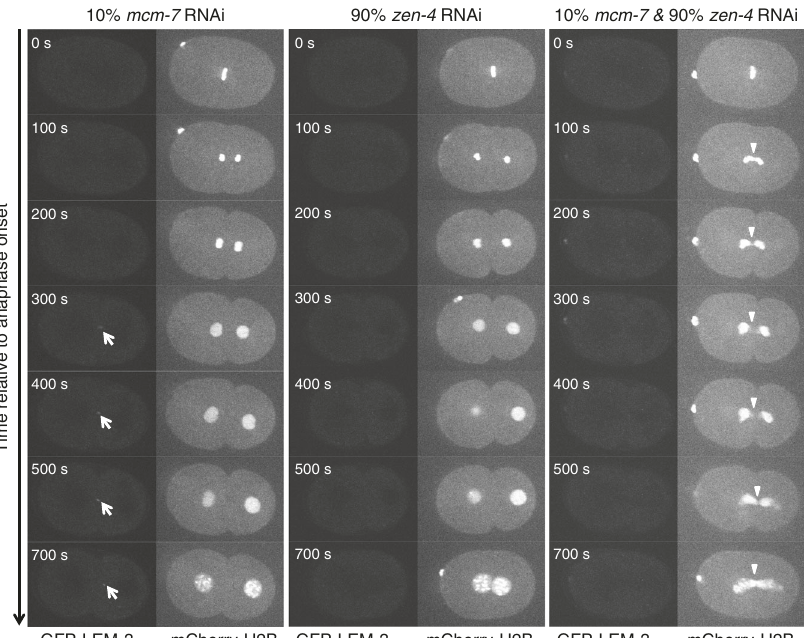
Fig. 4 Formation of chromatin bridges upon partial depletion of MCM-7 and central spindle component ZEN-4. Arrowheads indicate chromatin